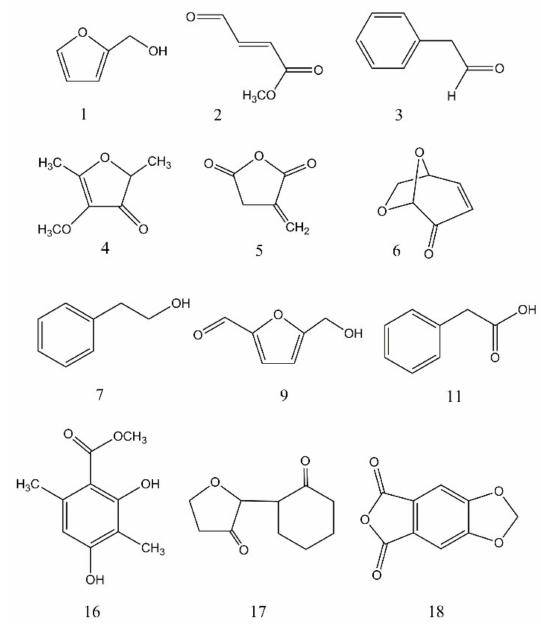
Figure 5. Structures of the volatile compounds tentatively identified from BS15 by comparison with the mass spectra in the NIST database. The compound numbers correspond to the peak numbers listed in Table 2 and in Figure